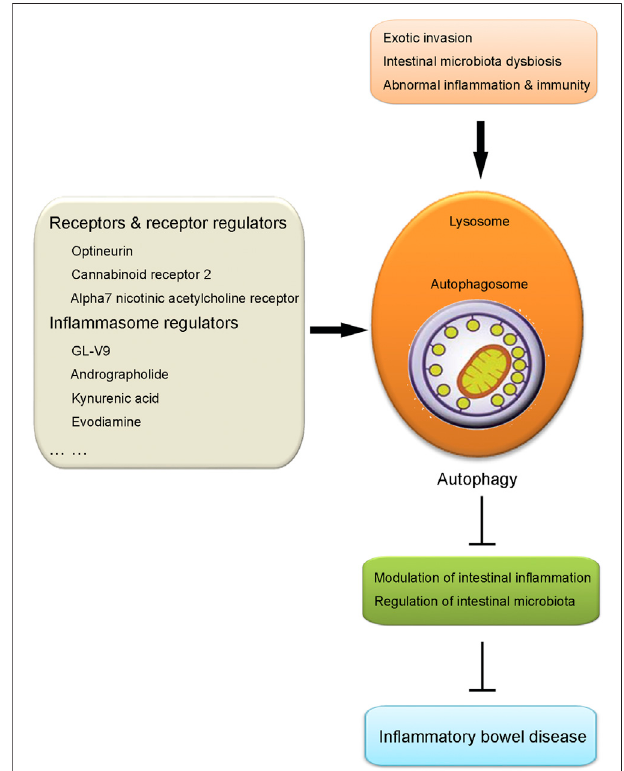
FIGURE 1 | Illustration of the role of intestinal macrophage autophagy in IBD. Under the challenge of certain pathological conditions including exotic invasion, intestinal microbiota dysbiosis and abnormal in fl ammation and immunity, autophagy process in macrophages is induced, which results in the suppression of intestinal in fl ammation and regulation of intestinal microbiota. Those effects produced by the induction of macrophage autophagy contribute to the protection against IBD. Several kinds of agents have been proven to alleviate IBD taking advantage of intestinal macrophage autophagy, including receptors and receptor regulators (optineurin, cannabinoid receptor 2, alpha7 nicotinic acetylcholine receptor) and in fl ammasome regulators (GL-V9, andrographolide, kynurenic acid, evodiamine),